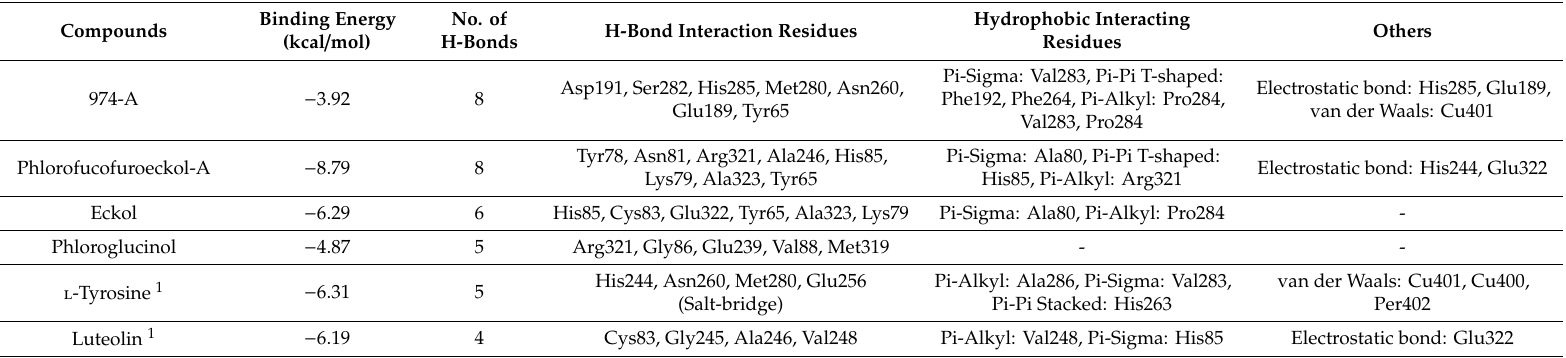
Table 2. Binding sites and docking scores of phlorotannins and reference compounds in oxy-form tyrosinase from Agaricus bisporus